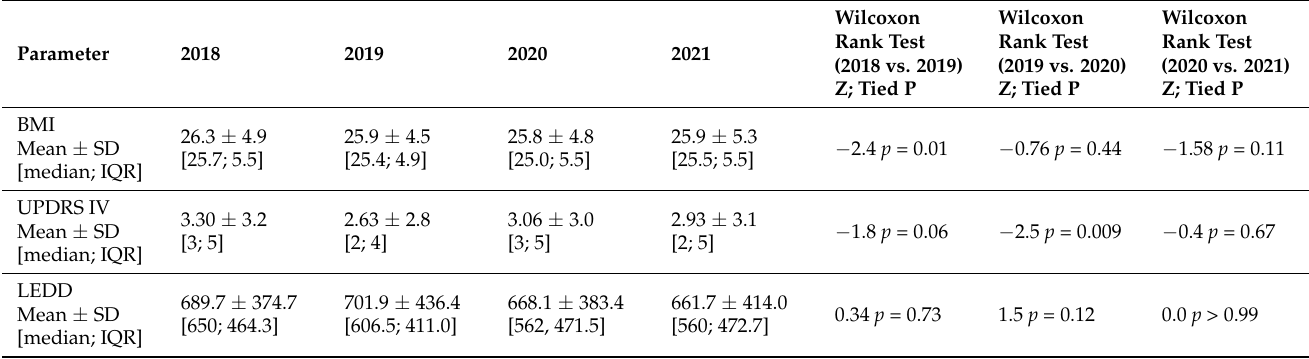
Table 4. Values of the secondary outcome measures (BMI, UPDRS IV, and LevoDopa Equivalent Daily Doses (LEDDs)) in the period of interest. Comparisons between measures taken in two consecutive years are presented. No statistically significant changes were observed over